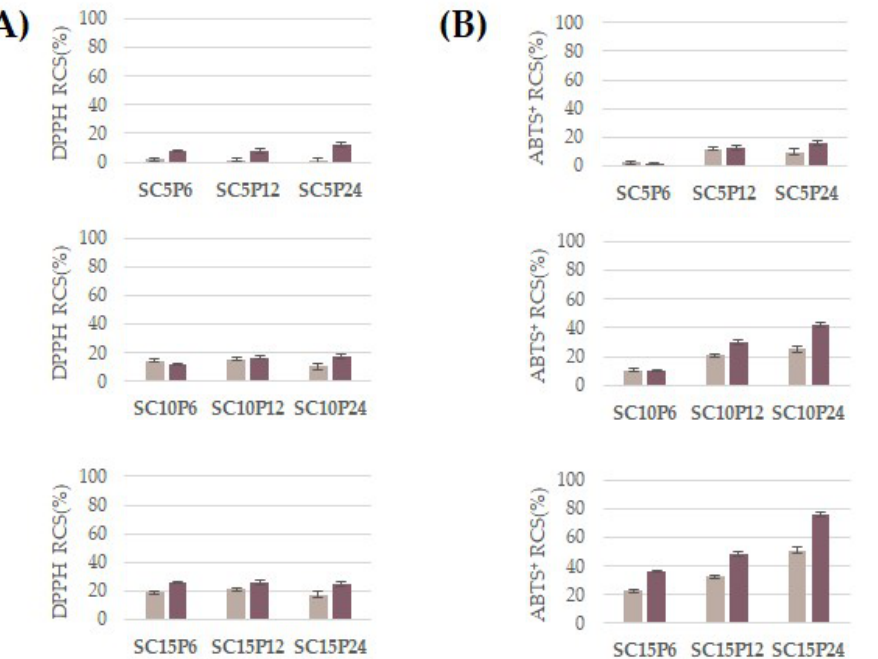
Figure 4. Radical Scavenging Capacity (RSC, %) of hybrids directly exposed to DPPH • ( A ) and ABTS • + ( B ) at 1.00 mg dose ( ● ) and 2.00 mg dose ( ● ). Values are the mean ± SD of measurements carried out on three samples analyzed three times.